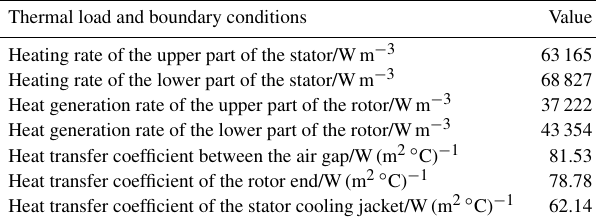
Table 2. Thermal model parameters considering